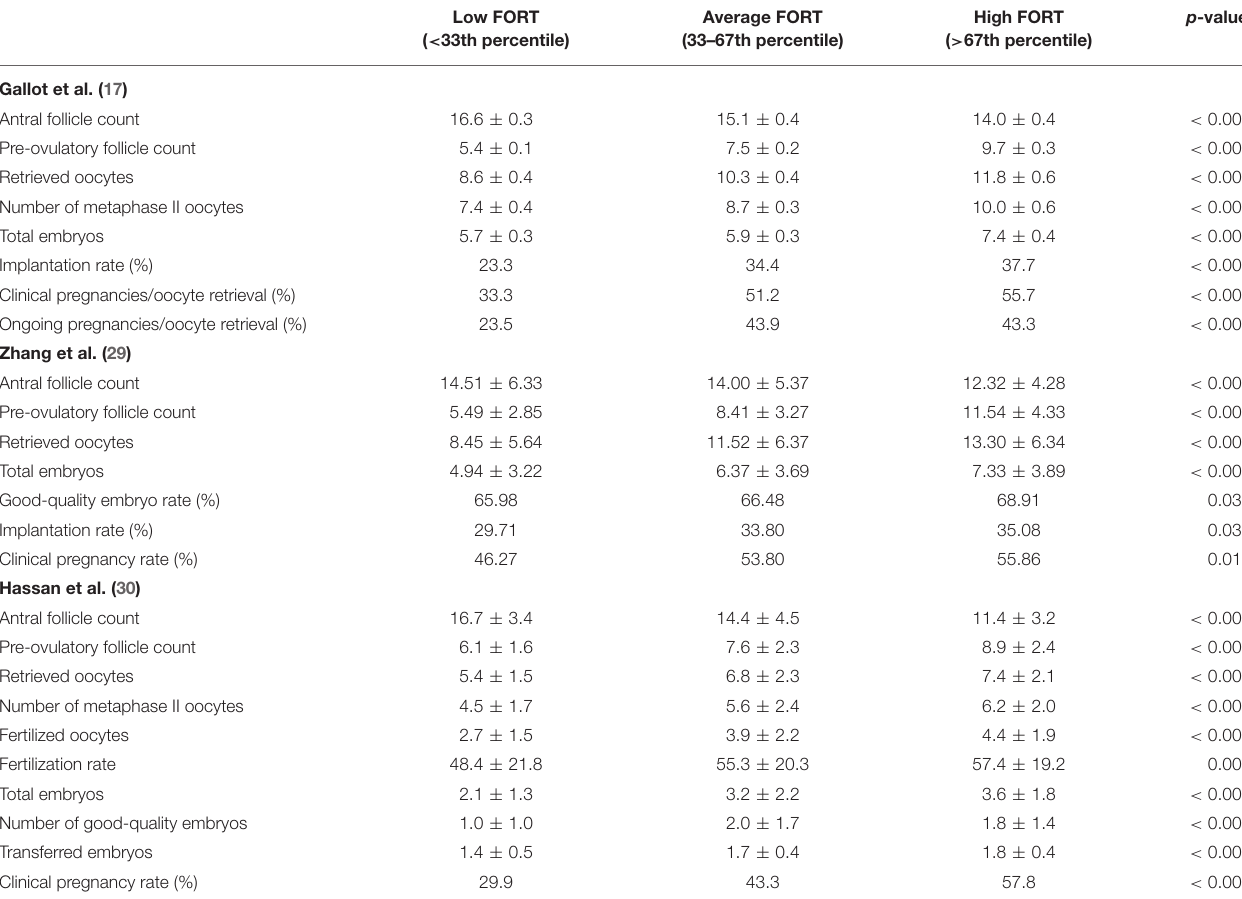
TABLE 1 | Results of IVF-embryo transfer and outcome in the low, average, and high FORT